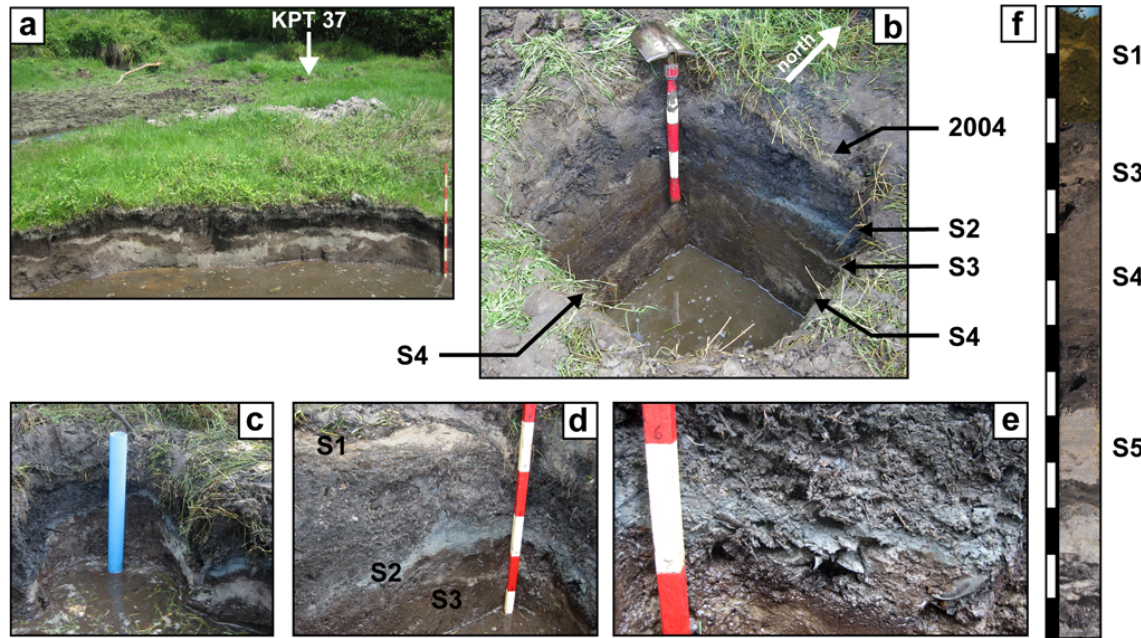
Fig. 5. The stratigraphy of KPT 37. (a) View from trench KPT 39 to the north with the location of pit KPT 37. (b) Northern and western wall of pit KPT 37 with three discontinuous sand sheets below the IOT 2004 deposit (S2-4). (c) Core KPT 37B directly next to the pit. (d) Detail photograph of sand layers S1 and S2 (greenish grey); they appeared to be two separate layers. (e) Laminated leaves at the top of S2. (f) Sediment core KPT 37 extends the stratigraphy down to the intertidal sand of unit 1 (each segment of the scale represents 10cm). While layer S2 is missing in the core, an additional layer S5 is